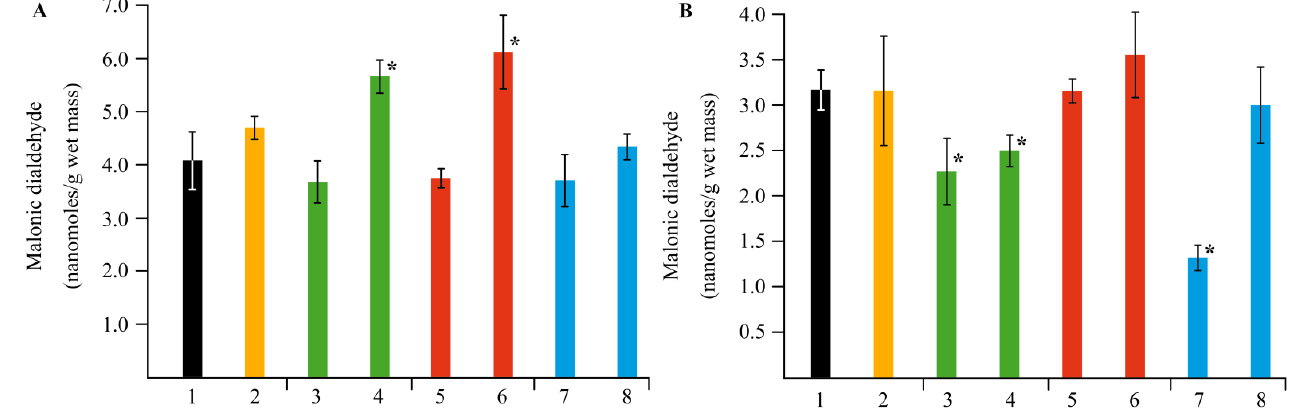
Figure 12. Effect of NC treatments on the content of malonic dialdehyde (MDA) in potato leaves ( A ) and roots ( B ), in comparison with the control group in vitro, as well as in plants infected by Cms pathogen; (1)—control without NCs and Cms , (2)—plants infected by Cms without NCs, (3)—AG-Mn without Cms , (4)—infected plants in the presence of AG-Mn, (5)—AGS-Mn without Cms , (6)—infected plants in the presence of AGS-Mn, (7)— κ -CG-Mn without Cms , (8)—infected plants in the presence of κ -CG-Mn; * p ≤ 0.01 compared to the control according to the Mann–Whitney test.